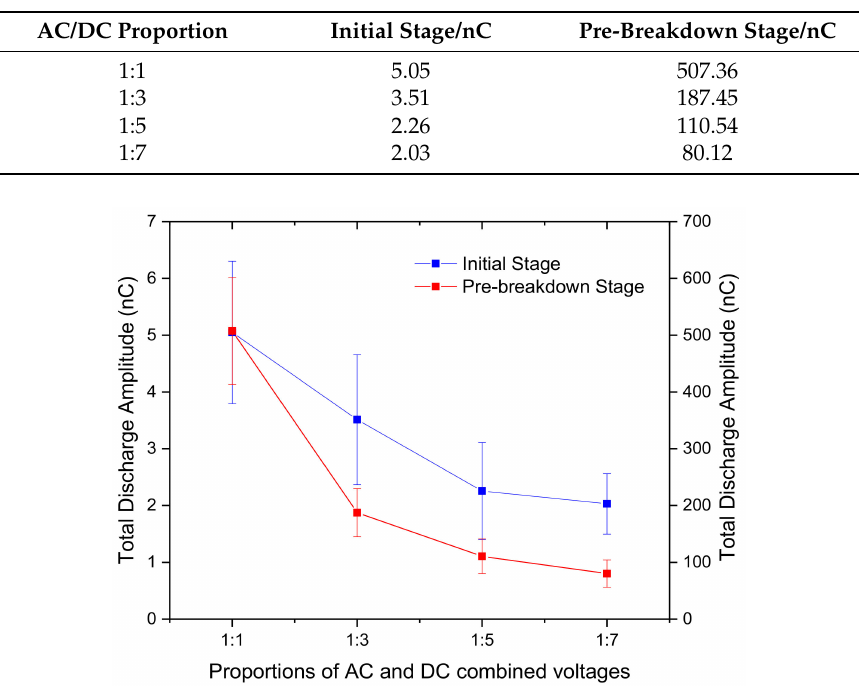
Figure 17. Relationship between total discharge amplitude and AC/DC proportions.